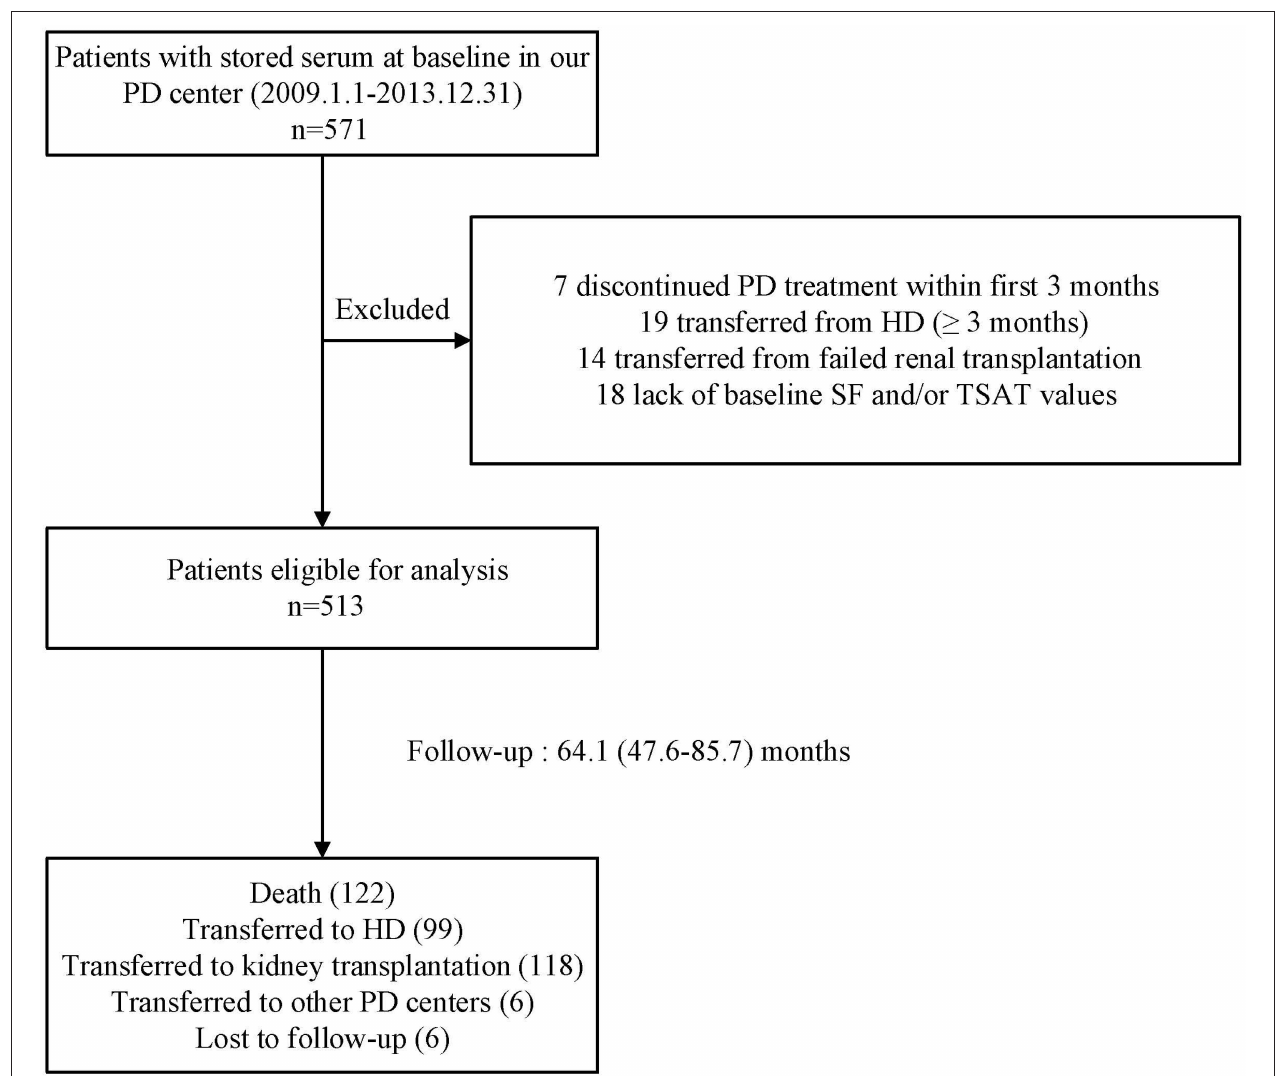
FIGURE 1 | Flow chart of the participants in the study cohort. PD, peritoneal dialysis; HD, hemodialysis; SF, serum ferritin; TSAT, transferrin saturation.